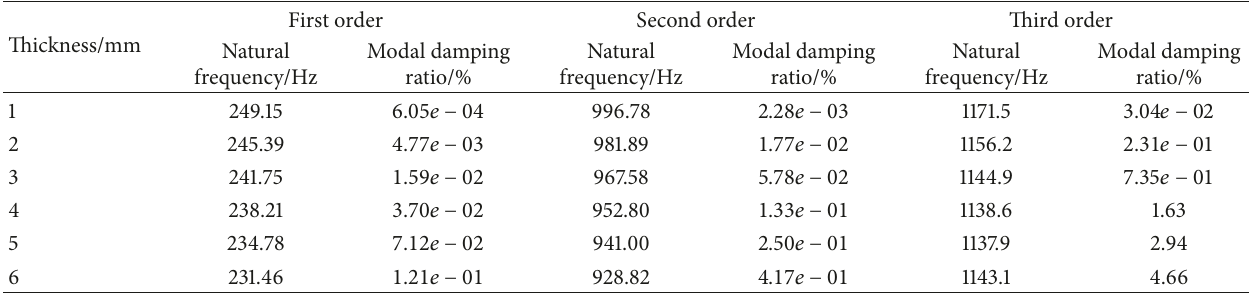
Table 7: Natural frequencies and modal damping ratios of the blade with different thickness of viscoelastic damping block.